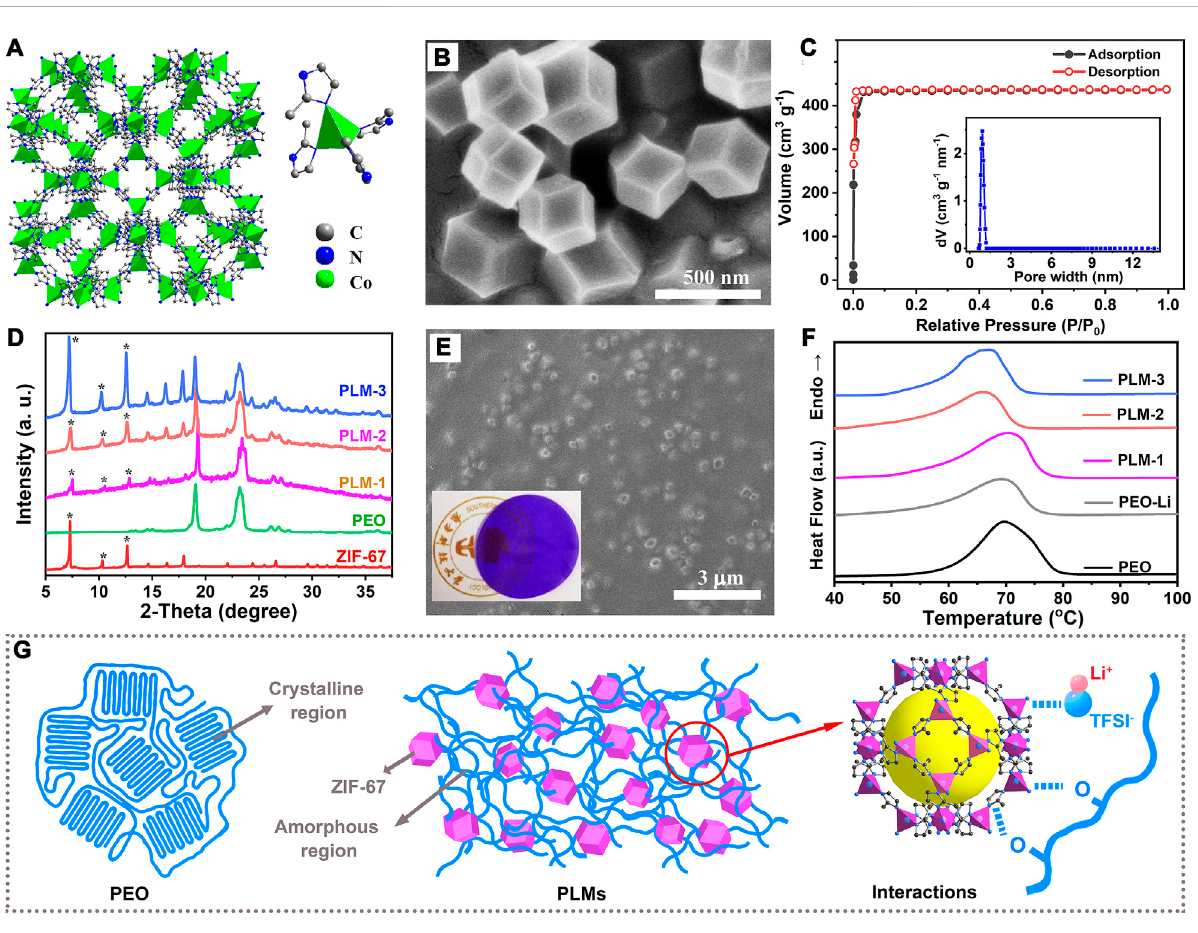
FIGURE 1 (A) The topology and coordination of ZIF-67. (B) The SEM image of ZIF-67. (C) The N 2 adsorption curve and pore size distributionof ZIF-67. (D) The XRD patterns of as-synthesized ZIF-67, PLM-1, PLM-2 and PLM-3. (E) The SEM image of PLM-2. Inset is the photo of PLM-2 fi lm. (F) The DSC curves of PEO, PEO-Li, PLM-1, PLM-2 and PLM-3. (G) Illustration of PLMs and the